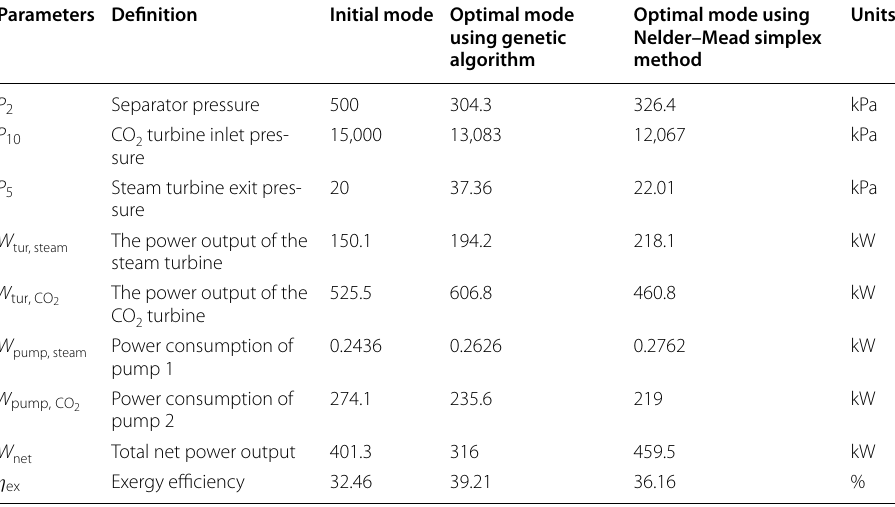
Table 4 Optimization results using genetic algorithm and Nelder–Mead simplex method Parameters